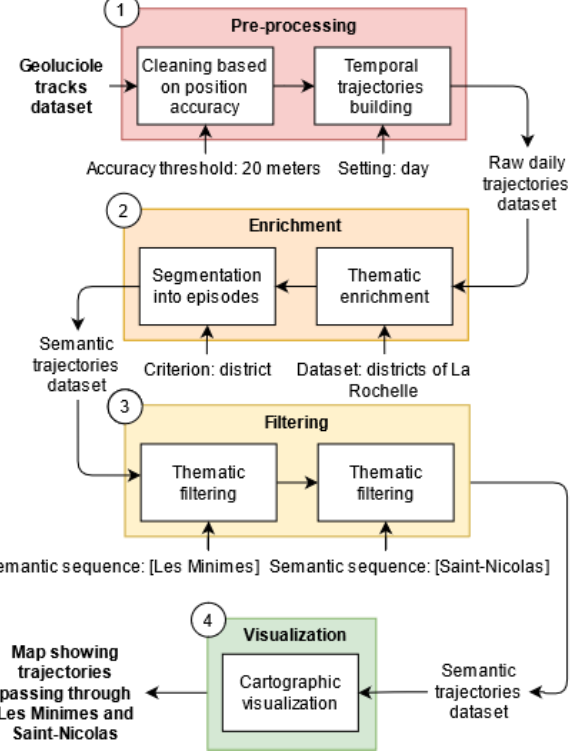
Figure 3. Customized processing chain to answer question